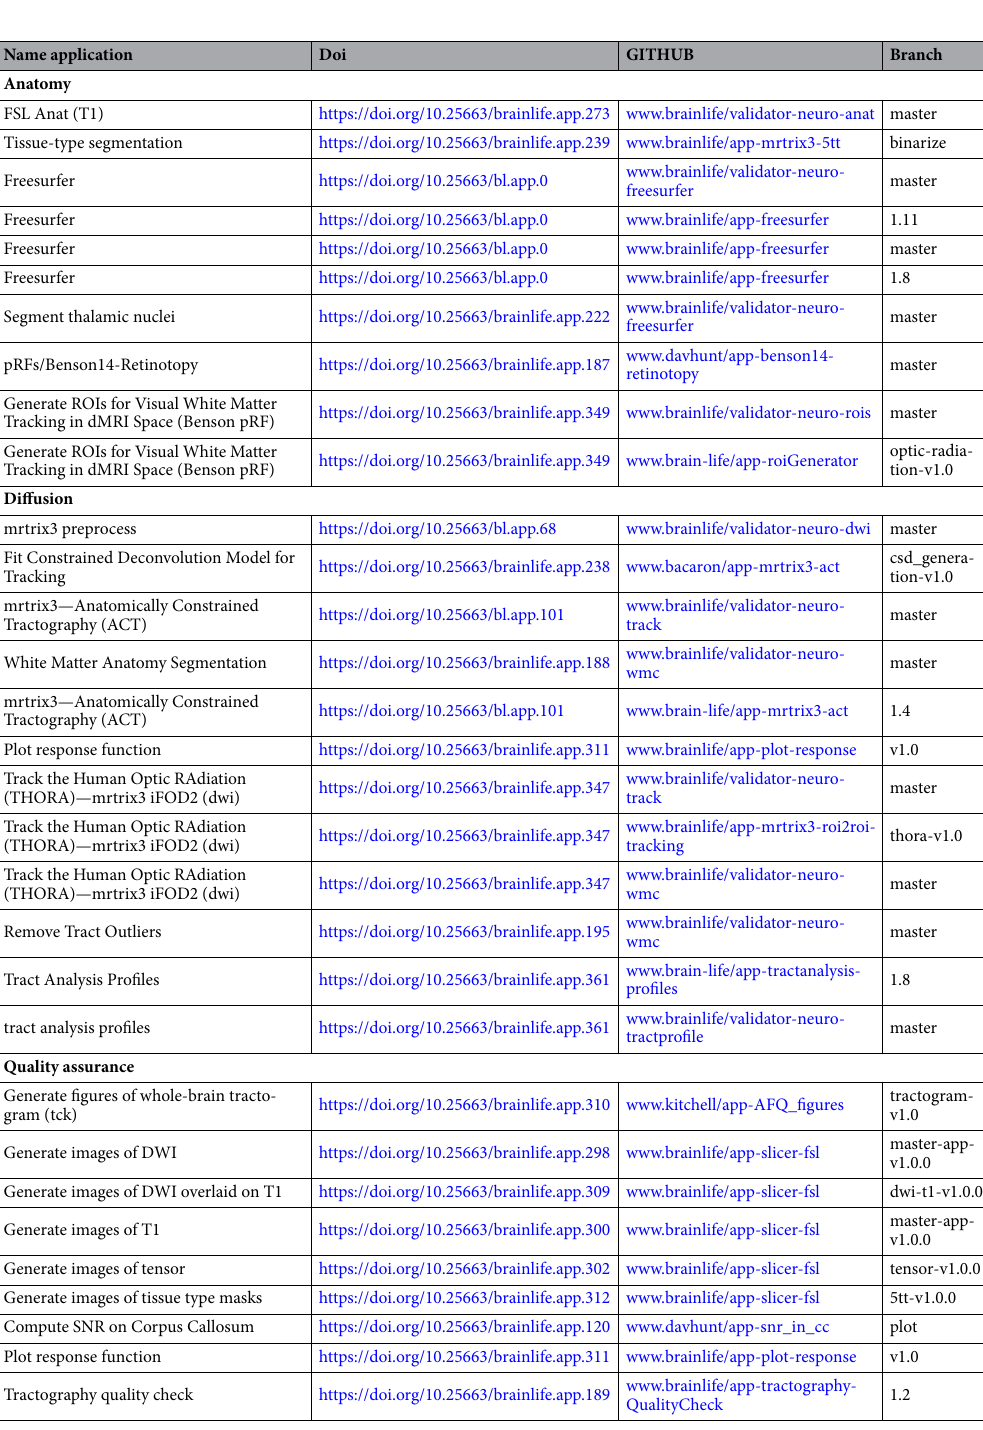
Table 3. Description and web-links to the open source code and open cloud services used in the creation of this